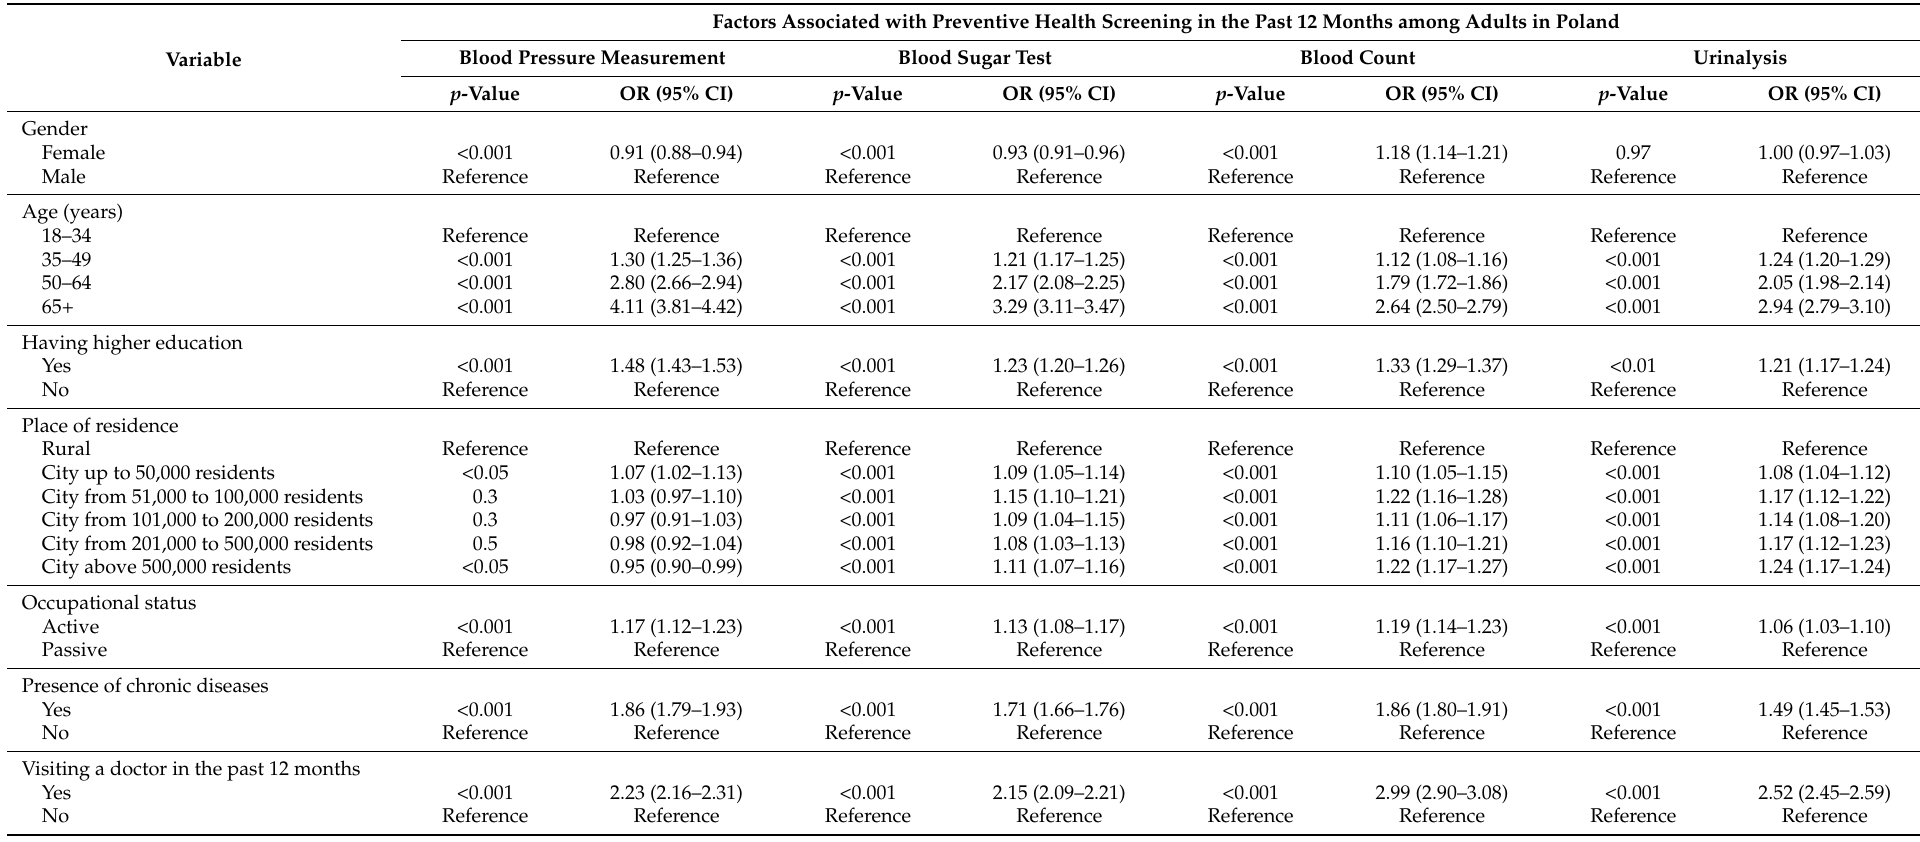
Table 5. Factors associated with preventive health screening in the past 12 months among adults in Poland ( n = 102,928)—multivariable logistic regression